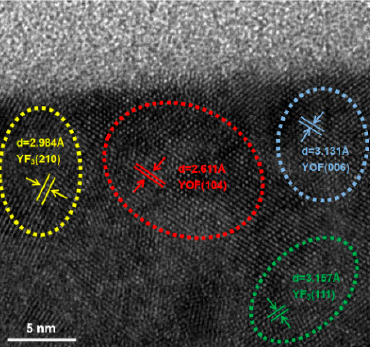
Figure 9. Cross-sectional high-resolution transmission electron microscopy (HRTEM) image of the YF 3 film after exposure to fluorine plasma.